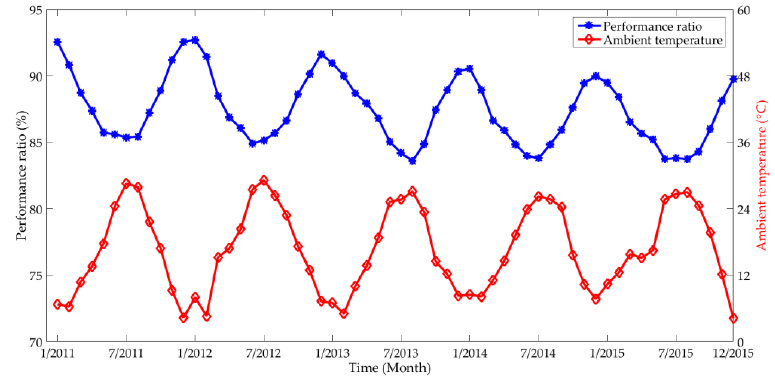
Figure 10. Monthly PR and ambient temperature for mono-Si PV.